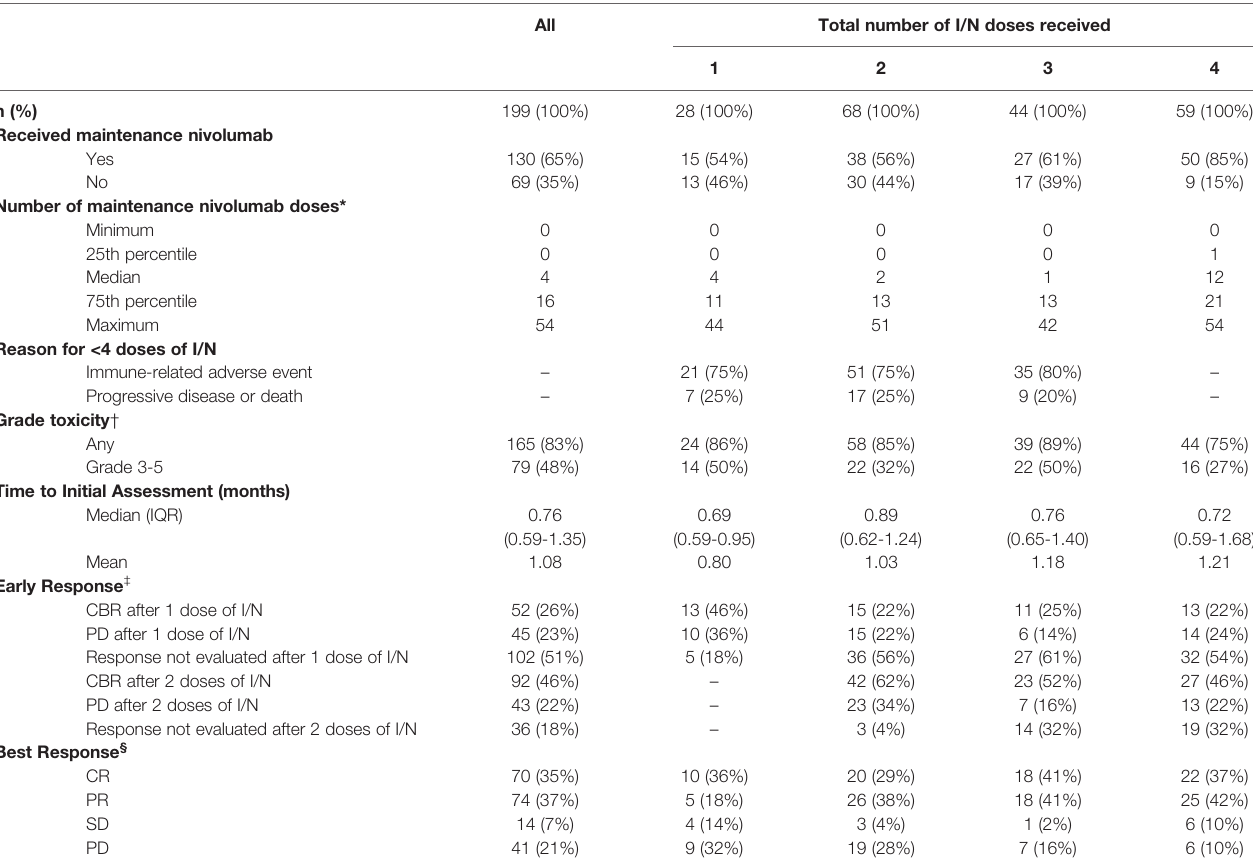
TABLE 2 | Patient treatment response and